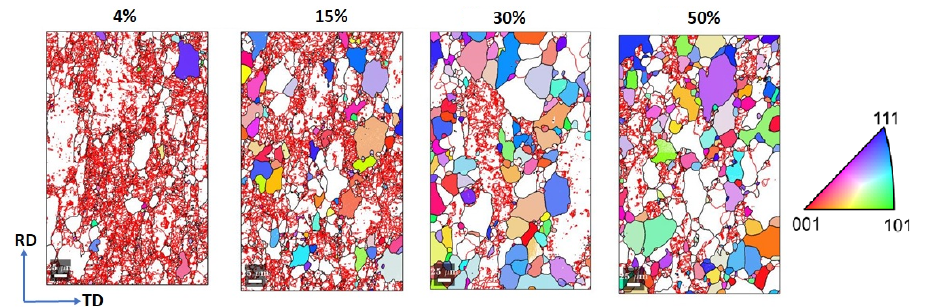
Figure 6. EBSD maps representing the evolution of softening fraction at T = 1550 ◦ C. The grain boundaries are in black, the sub-grain boundaries are in red and the recrystallized grains are colored according to (IPF Z—normal